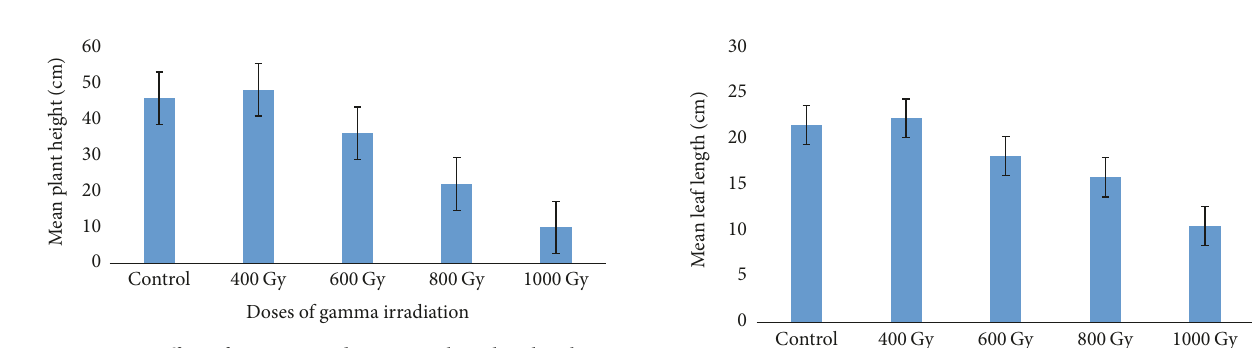
Figure 2: Effect of gamma irradiation on okra plant height.